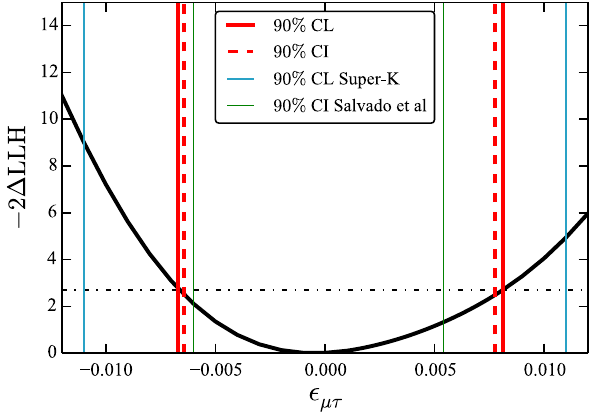
Fig. 19 Confidence limits on the NSI parameter (cid:3) μτ using the event selection from [79,129] shown as solid vertical red lines. Similarly, dashed vertical red lines show the 90% credibility interval using a flat prior on (cid:3) μτ and where we have profiled over the nuisance parameters. The light blue vertical lines show the Super-Kamiokande 90% confi- dence limit [130]. The light green lines show the 90% credibility region from [131]. Finally, the horizontal dash-dot line indicates the value of − 2 (cid:18) LLH that corresponds to a 90% confidence interval according to Wilks’ theorem. Figure from [132]